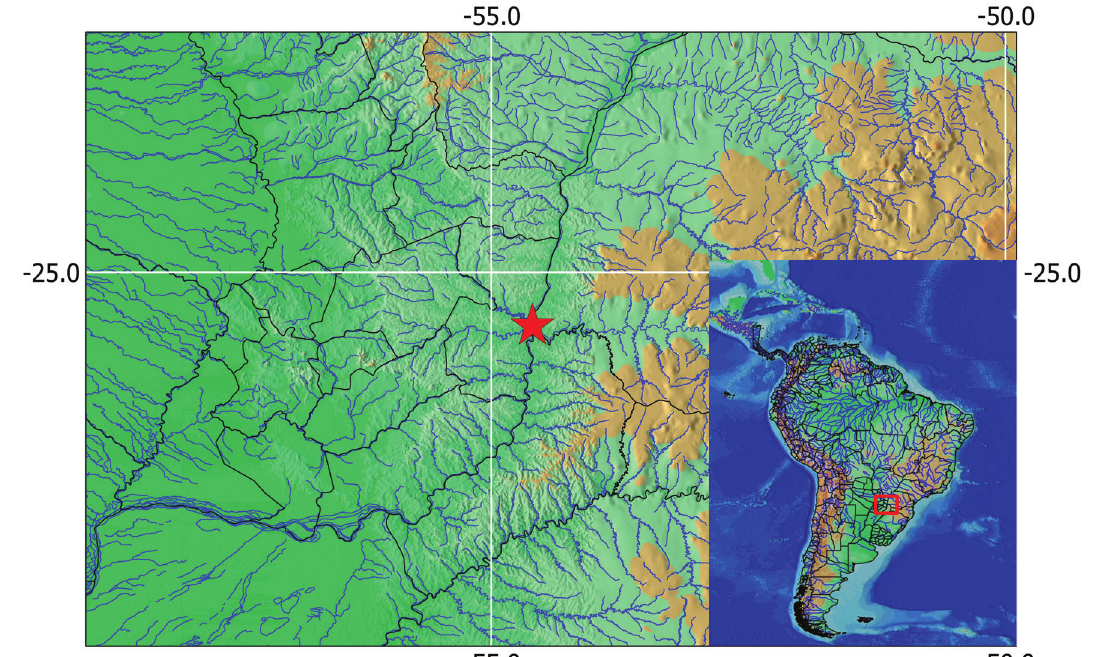
Fig. 4. Map showing the type locality (red star) of Corydoras gryphus , rio Paraná near Itaipu dam,